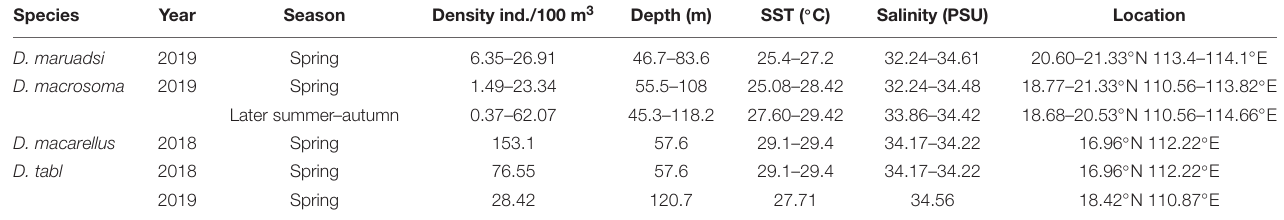
TABLE 2 | Decapterus egg distributions in the northern South China Sea.